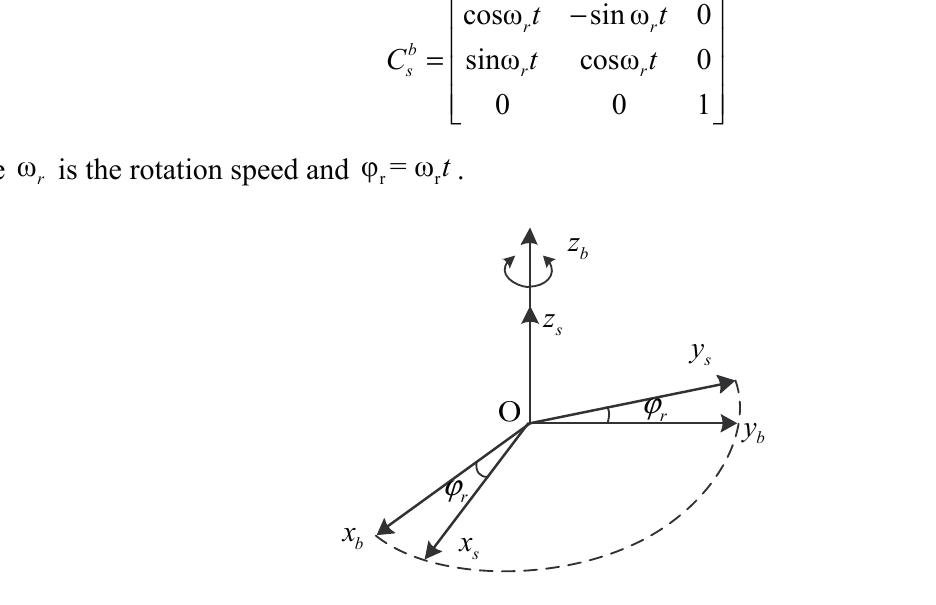
Figure 3. Rotation along with the Z